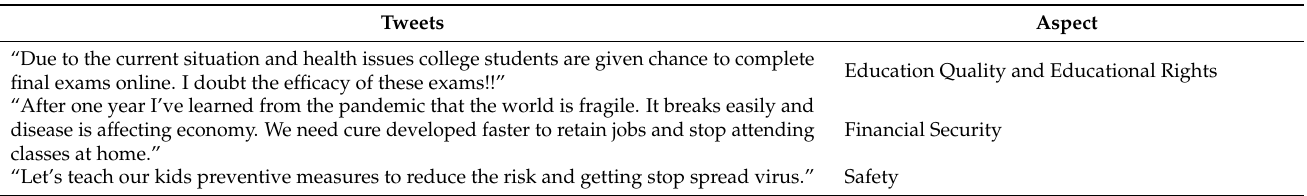
Table 8. Aspect analysis results